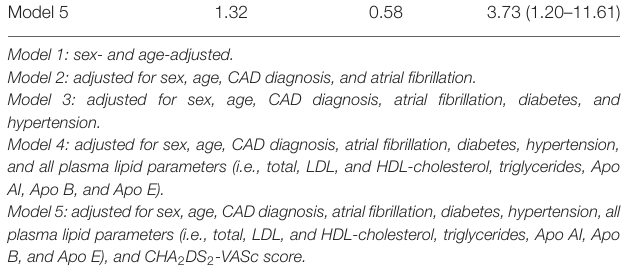
Model 3: adjusted for sex, age, CAD diagnosis, atrial fibrillation, diabetes, and hypertension. Model 4: adjusted for sex, age, CAD diagnosis, atrial fibrillation, diabetes, hypertension, and all plasma lipid parameters (i.e., total, LDL, and HDL-cholesterol, triglycerides,